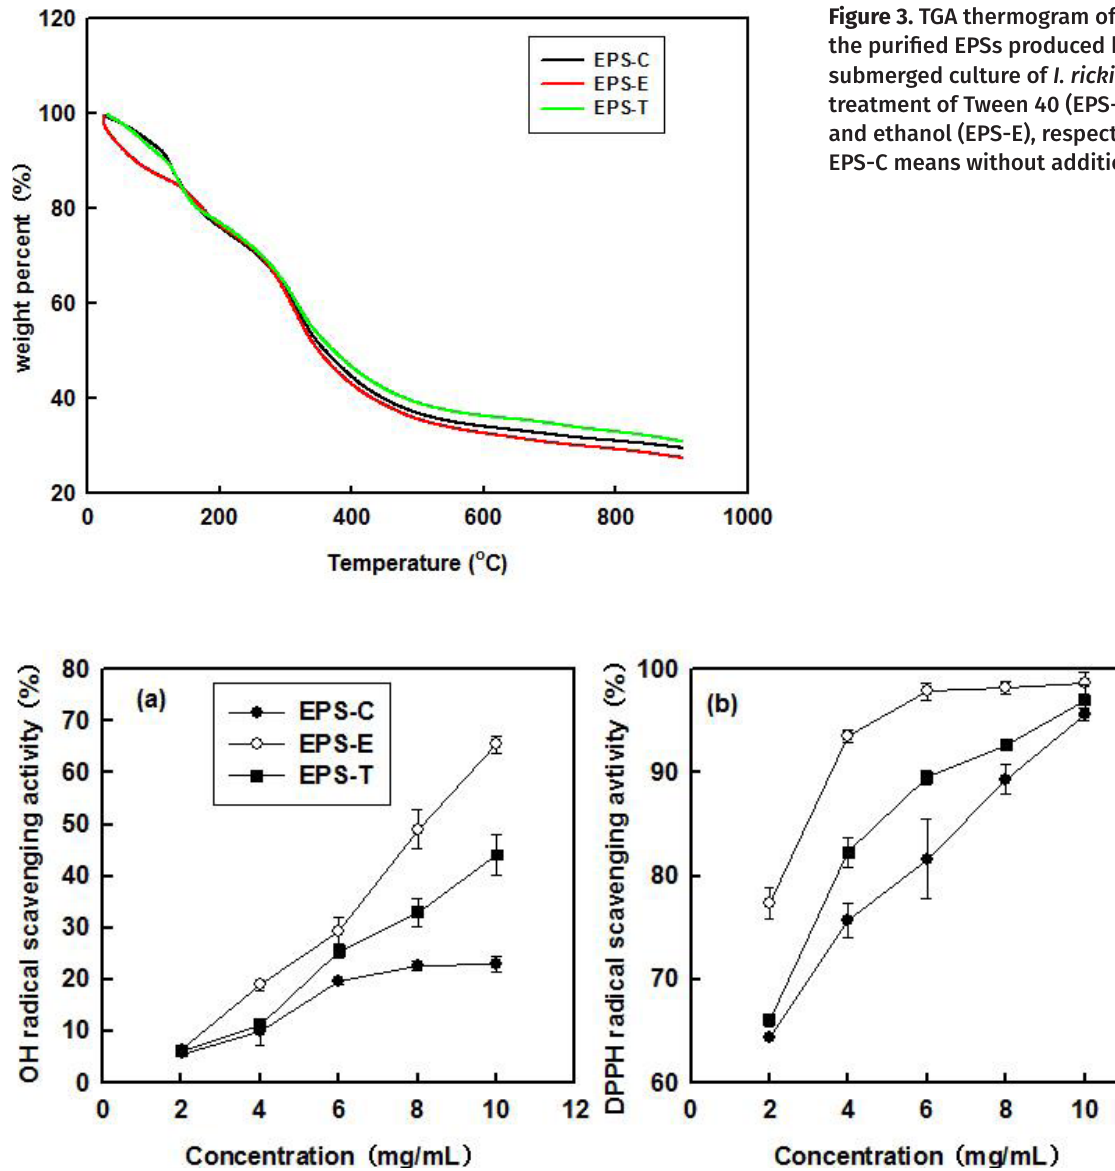
Figure 4. Bioactivity of EPS produced by submerged culture of I. rickii by treatment of Tween 80 (EPS-T) and ethanol (EPS-E), respectively. The results represent mean ± S.D. (n = 3). OH• (a) and DPPH (b) radical scavenging activity of EPS. EPS-C means without